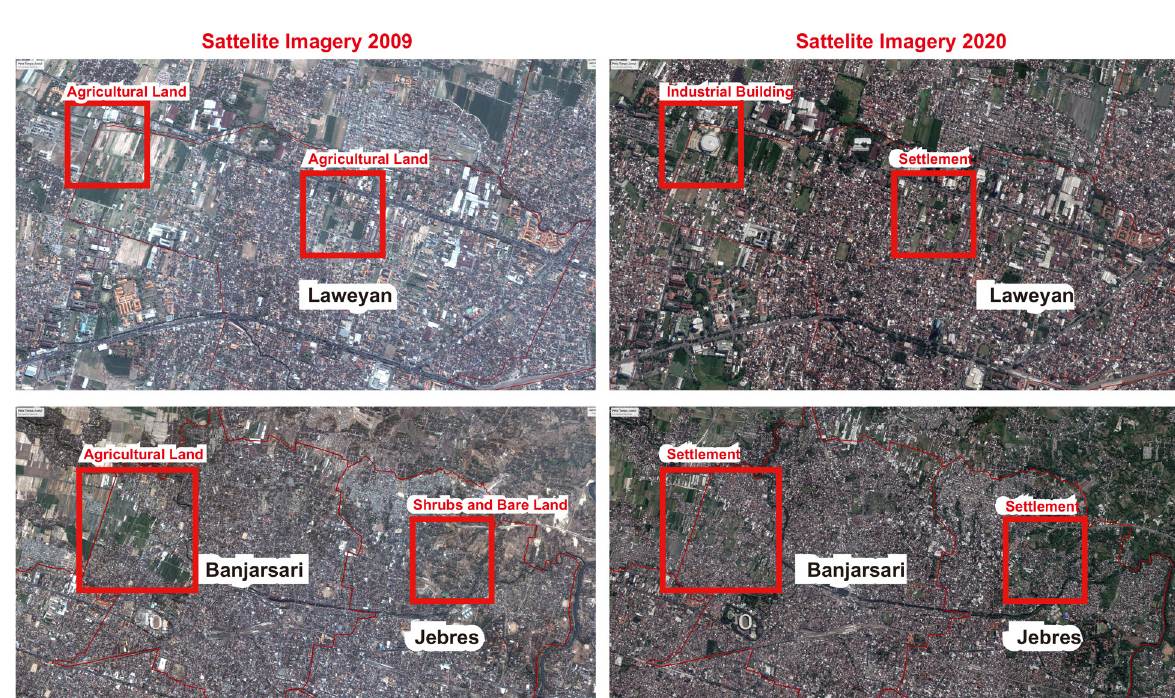
Fig. 1. Several locations of landuse change in Surakarta City during